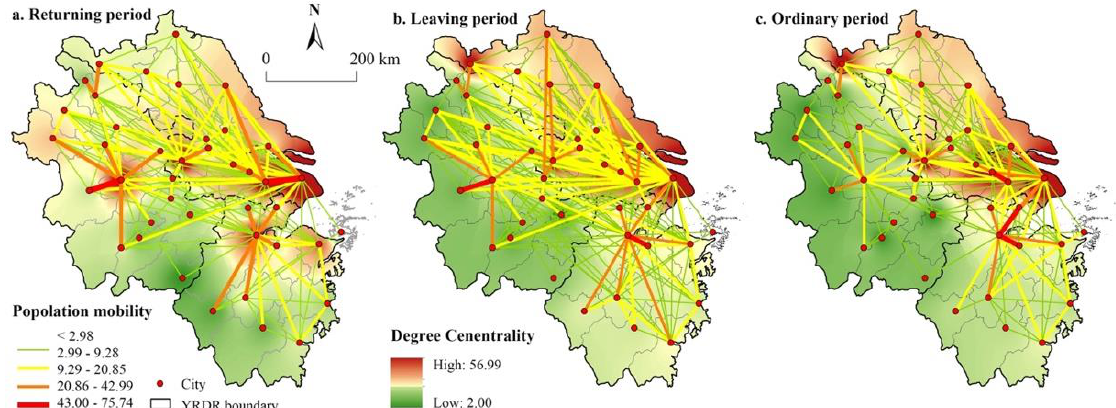
Figure 5. Spatial patterns of population flow networks and node degree centrality in the Yangtze River Delta Region.